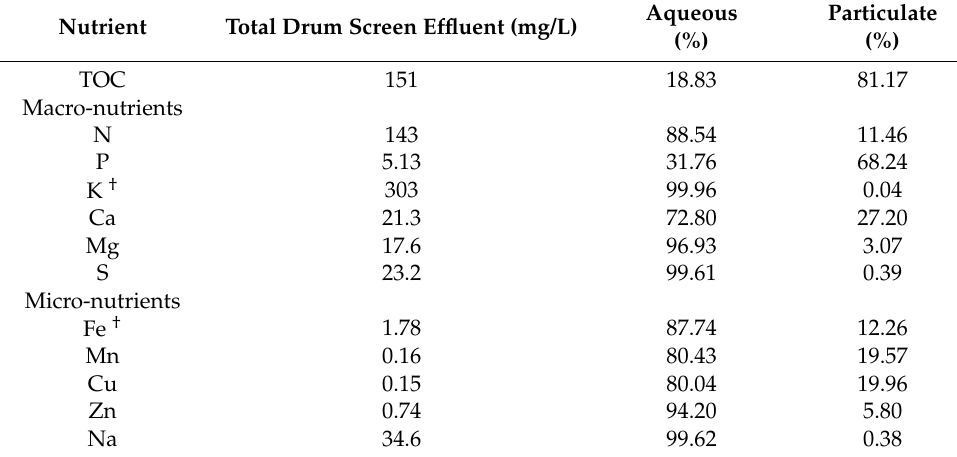
Table 2. Effluent nutrient analysis. Total nutrient concentrations in the drum screen effluent collected from UNH KFRAG as a combination of the aqueous and particulate nutrient mass normalized to 1 L of